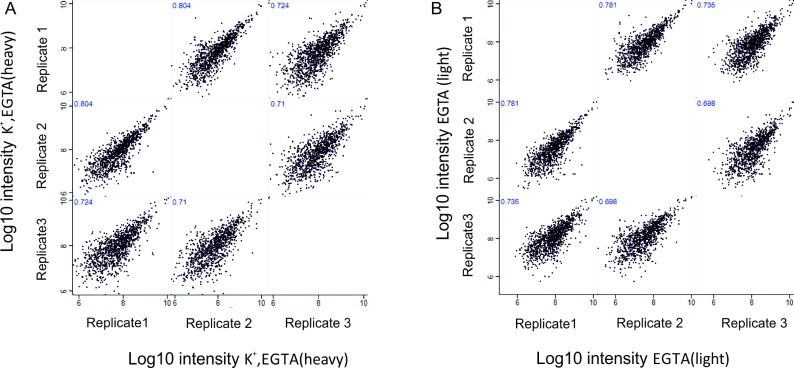
Correlation of phosphosites between biological replicates.Correlation plots depicting correlation of phosphosites between three biological replicates at Log10 intensity level in depolarization without Ca2+ (K+, EGTA, heavy) condition (A), no depolarization (EGTA, light) condition (B).